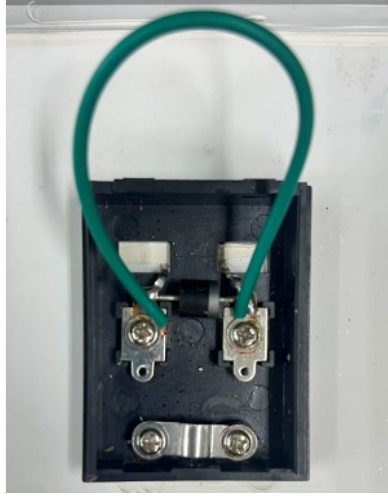
Figure 7 . Diode short circuit . Figure 7. Diode short circuit.